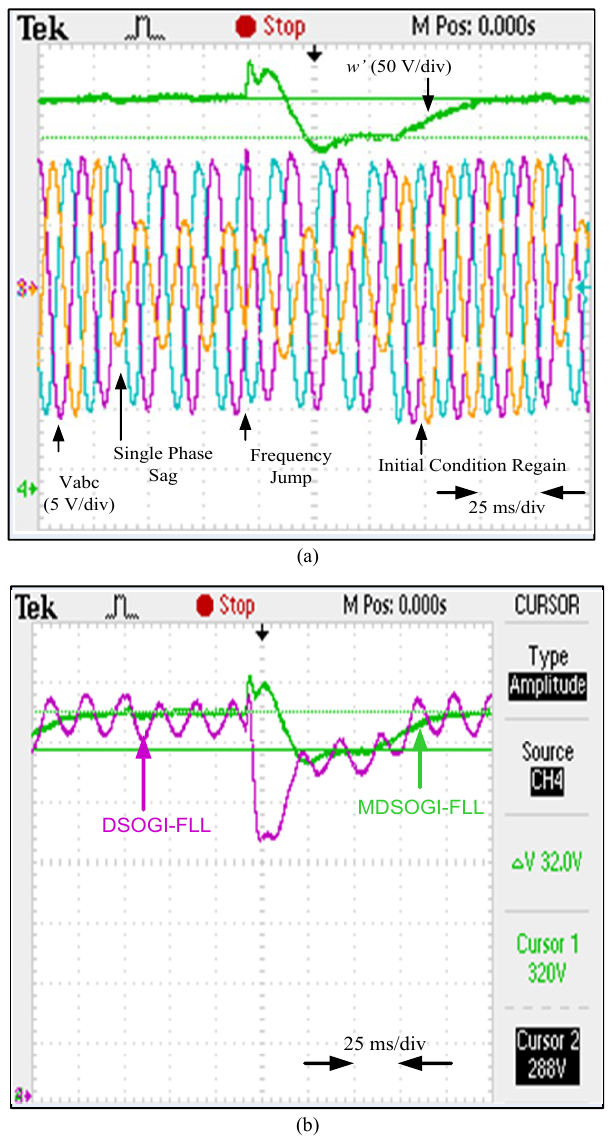
Fig. 10. Experimental results with imbalance and dc-offset in supply voltage: (a) Three-phase grid voltage (b) Estimated frequency with DSOGI-FLL and MDSOGI-FLL.